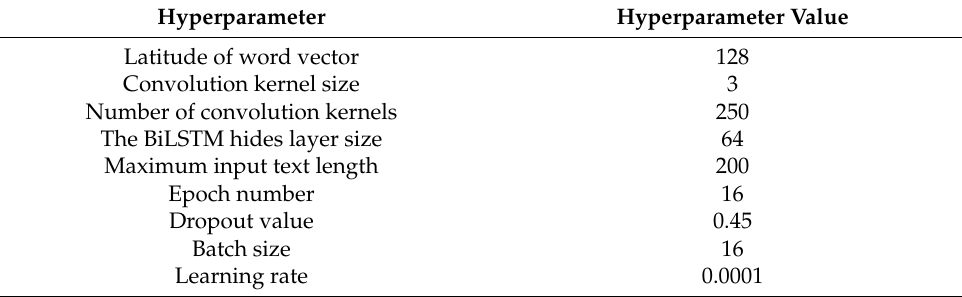
Table 7. The setting of model